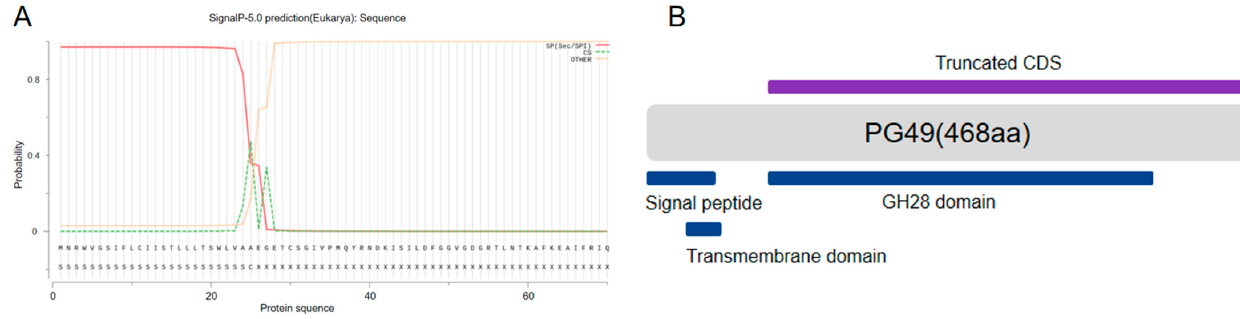
Figure 4. SlPG49 displays PG activity in vitro: ( A , B ) signal peptide analysis and schematic protein structure of SlPG49; ( C ) SDS-PAGE analysis; M, protein maker; 1, not induced pMAL-MBP; 2, induced pMAL-MBP; 3, not induced pMAL-MBP- SlPG49; 4, induced pMAL-MBP-SlPG49. White arrowheads show the bands of pMAL-MBP-SlPG49 and pMAL-MBP; ( D ) western blot analysis; 1: purified pMAL-MBP; 2; purified pMAL-MBP-SlPG49; ( E ) purified pMAL-MBP-SlPG49 shows PG activity in vitro. Data are presented as mean ± SE with at least three biological replicates. Significant differences are indi- cated by different letters ( p < 0.05). 4. Discussion According to the latest classification system, PGs can be divided into seven clades (A–G), and most members of clade E can be detected at a high overall expression in all tissues [45]. In the present work, phylogenetic analysis showed that SlPG49 was located in clade E and closed to ATPG5 (Figure 1D). Interestingly, the expression of ATPG5 was significantly increased when an Arabidopsis endo-PG ( AtPGLR ) was knocked out, indicat- ing that ATPG5 has the function of replenishing AtPGLR , which may also be an endo-PG [29]. Therefore, in view of the close evolutionary relationship between SlPG49 and ATPG5, we speculated that SlPG49 was probably an endo-PG. As mentioned earlier, PG has four conserved domains ( Ⅰ-Ⅳ ). Generally, genes encoding the proteins of these four domains are defined as PG genes. Notably, domain Ⅲ is relatively poorly conserved [46]. The re- sults of multiple sequence alignments show that the conservation of domain III is indeed lower than that of domains Ⅰ , Ⅱ , and Ⅳ (Figure 1D). Although they are different from the typical domain Ⅲ , the nine PGs from clade E (including SlPG49) are highly conserved in domain Ⅲ . It has been reported that the positively charged domain Ⅳ may participate in an ionic interaction with the carboxyl terminal of the substrate [47]. Here, although R (Ar- ginine) in the domain Ⅳ of SlPG49 is replaced by H (Histidine), it is still positively charged. Therefore, we speculated that the structure and function of SlPG49 may not have been changed. A previous study showed that the enzymatic activity of PG increased during the rip- ening period of the tomato fruit, suggesting that these enzymes may be critical for initiat- ing the ripening process [21]. In our previous research, SlPG49 was predicted to have a high expression in red ripening fruits [18]. In this work, qPCR analyses confirmed that